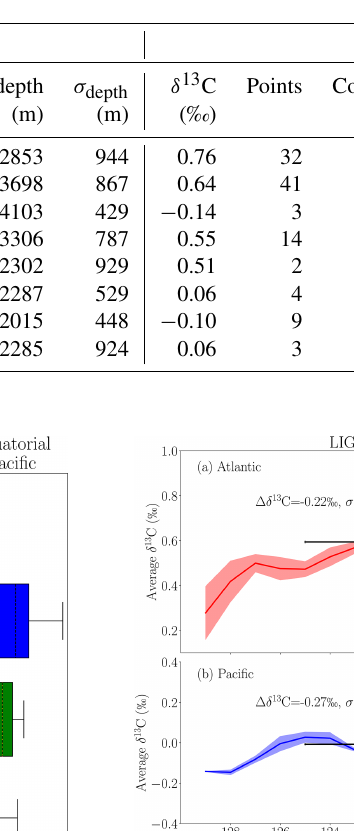
Table 4. Regional breakdown of δ 13 C data for all depths during the Holocene (7–2kaBP) and LIG (125–120kaBP) averaged across the 1kyr time slices. For each region: the average number of data points (labelled as “Points”) and cores per time slice (labelled as “Cores”), the average standard deviation of δ 13 C per time slice (‰), the mean depth (m) across time slices, and the standard deviation of depth (m) between time slices ( σ depth ). Regions are abbreviated as follows: NEA: northeastern Atlantic; NWA: northwestern Atlantic; SA: southern